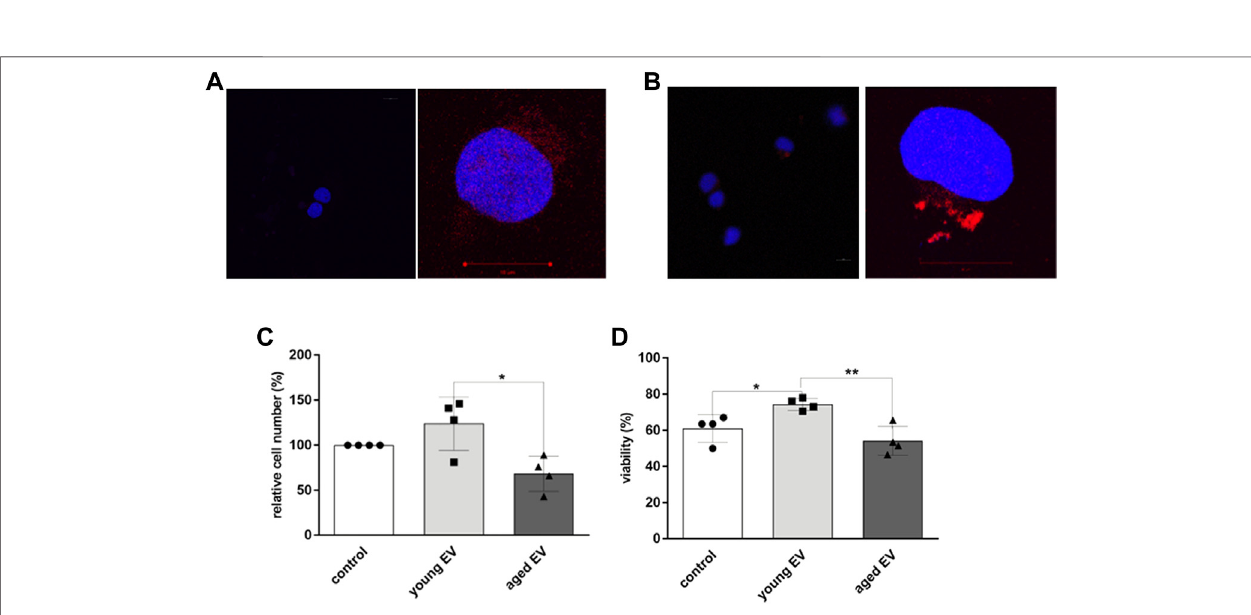
FIGURE 3 | Uptake of MSC-EVs and effects on HSPCs. HSPCs were either treated for 24 h with buffer (A) or with Dil-labeled EVs (B) . Representative images of confocallightmicroscopyareshownforlower(×20,left)andhighermagni fi cation(×63,right),nucleusofHSPCsisstainedwithDAPI(blue),EVsarelabeledwithDiI(red). Scalebar10 μ m.Thecellnumber (C) andviability (D) wasdeterminedbytrypanebluestainingandcountingofHSPCsafter72 hofincubationwithyoungoragedMSC- EVs or buffer as control, respectively. Bars represent the mean ± SEM from four different HSPC donors in each group (n = 3), * p < 0.05, ** p <